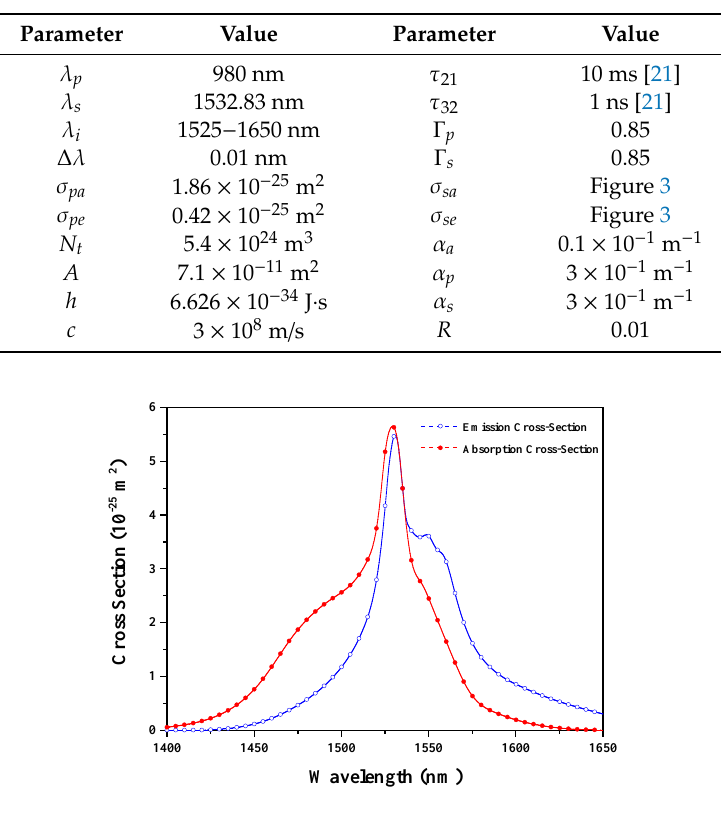
Figure 3. Emission and absorption cross-sections of the EDF [24].